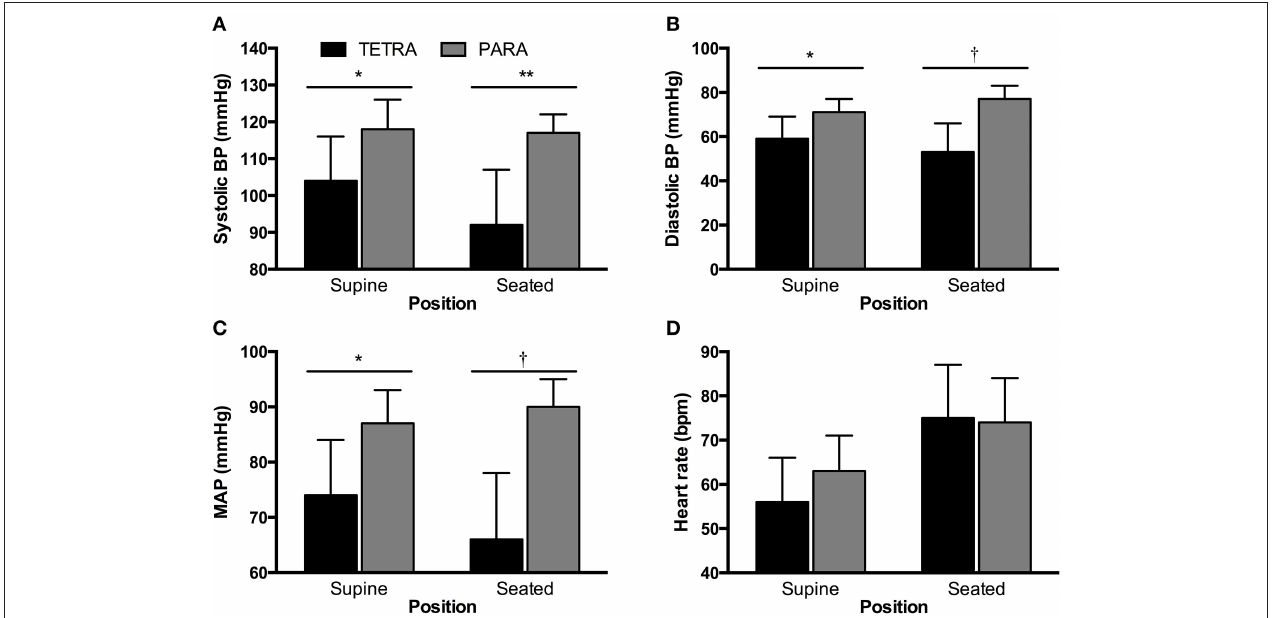
FIGURE 1 | Supine and seated systolic (A) and diastolic (B) blood pressure (BP), mean arterial pressure (C, MAP) and heart rate (D) for TETRA (black bars) and PARA (gray bars) groups. Between-group differences: * p < 0.05; ** p < 0.01; † p ≤ 0.001.